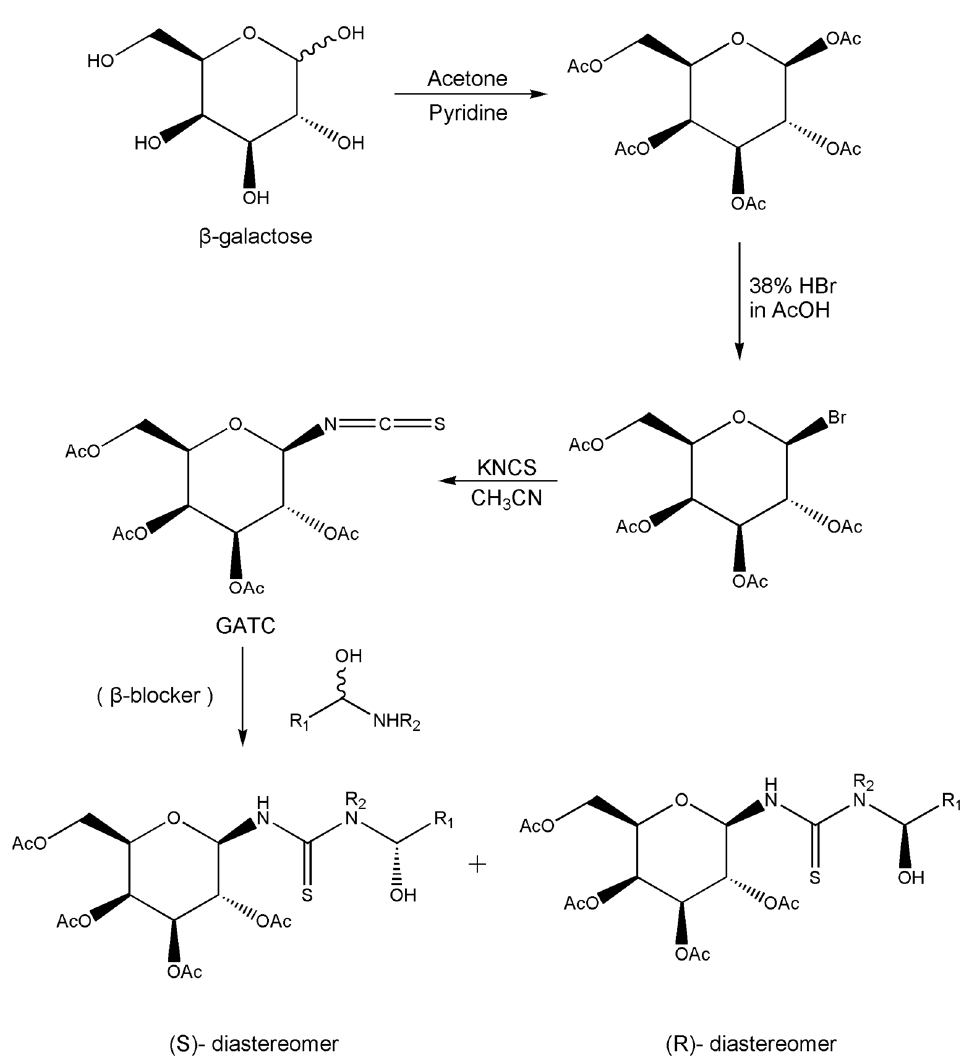
Figure 3. Scheme of the synthesis route of GATC and formation of diastereomers of β -blockers